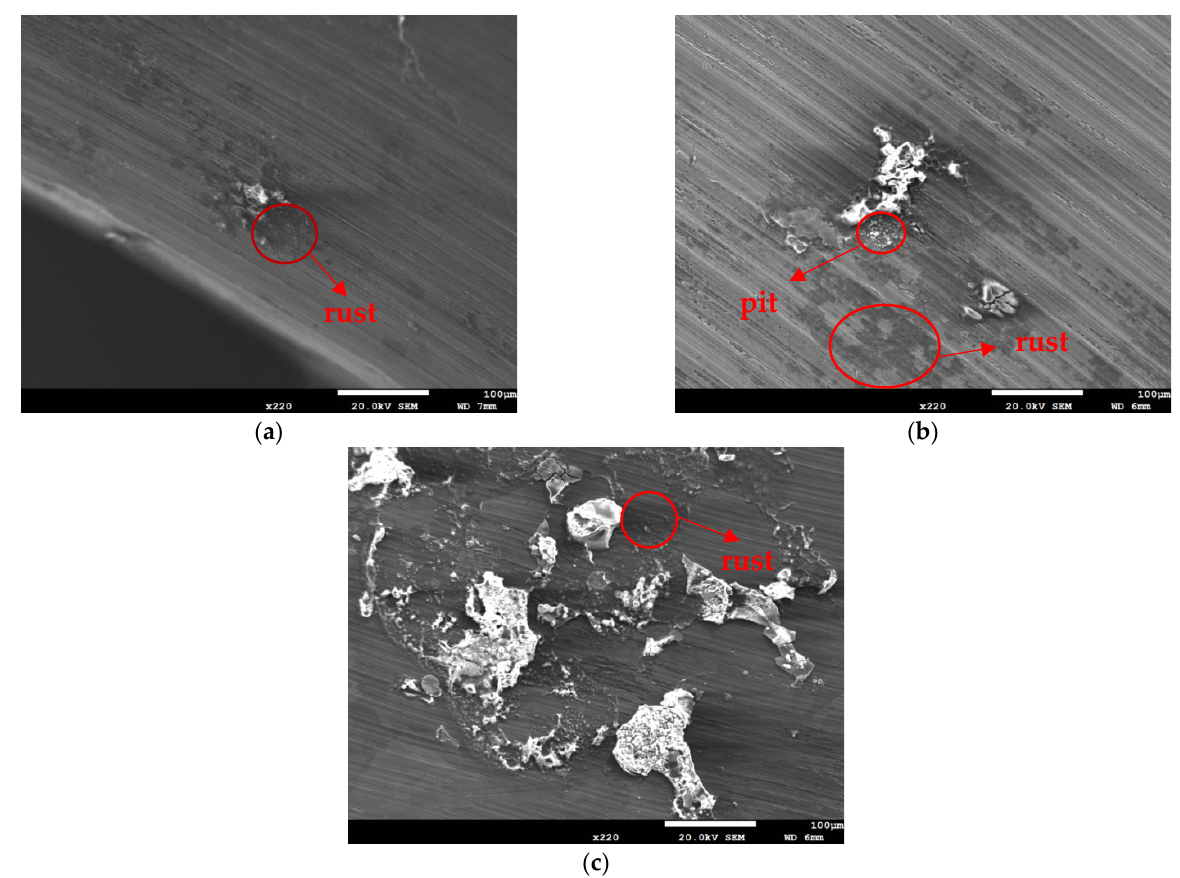
Figure 8. SEM micrographs of those samples with a chloride concentration of 1 g/m 2 after 7000 h of testing at: ( a ) RH = 45%, ( b ) RH = 55%, and ( c ) RH = 70%.